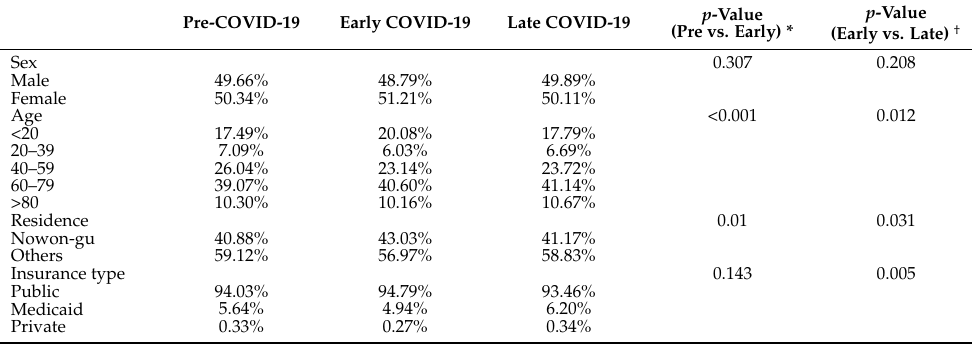
Table 2. Differences in age, gender, residence, and other patient factors by period (pre-COVID-19, early COVID-19, and late COVID-19).